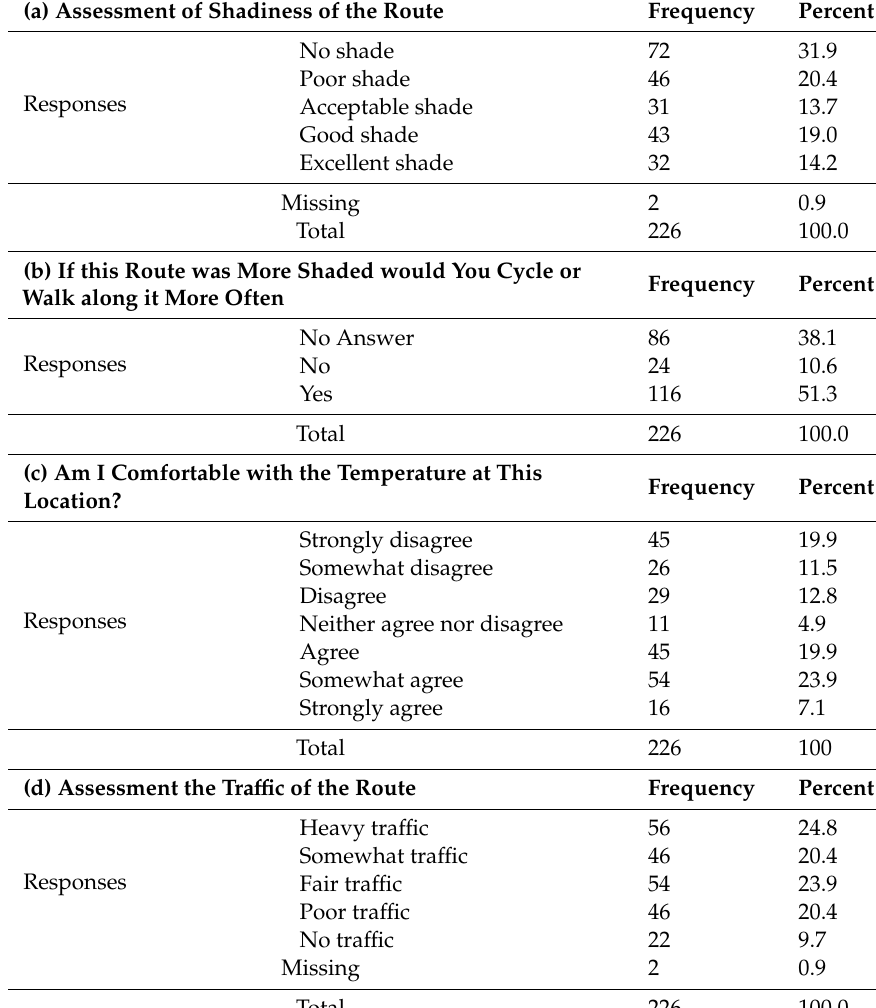
Table 5. Descriptive statistics derived from geographic information system (GIS)